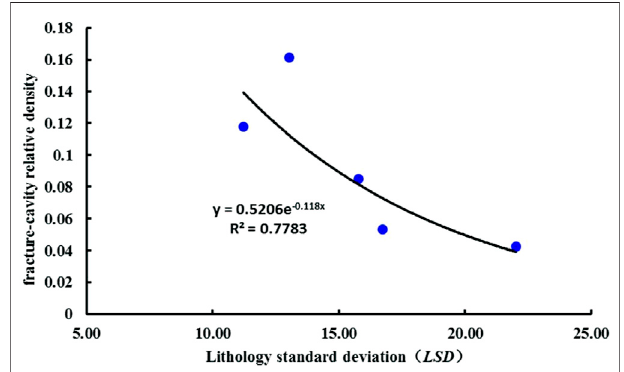
FIGURE7| Relationshipbetweenlithologystandarddeviation(LSD)and fracture – cavity relative density.